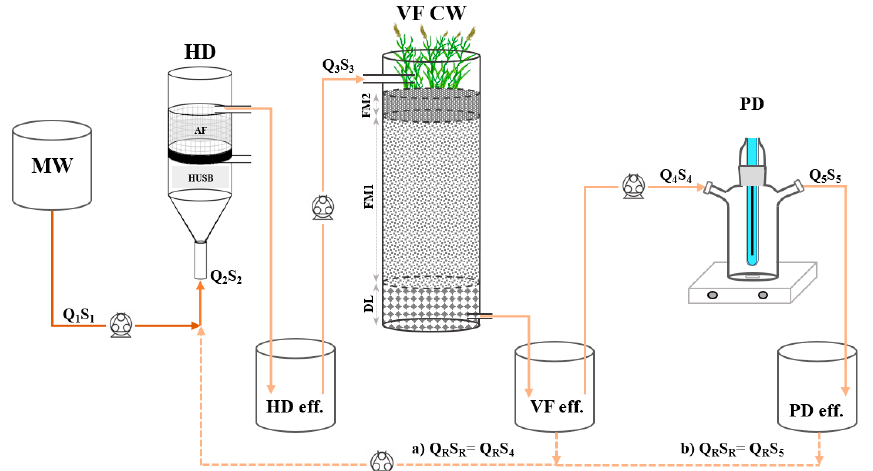
Figure 1. Scheme of the combined HD–VF–PD system with recirculation of VF effluent (a) or PD effluent (b). Acronyms: MW, municipal wastewater; HD, hybrid digester; VF, vertical flow unit; FM, filtering medium; DL, drainage layer; PD, photodegradation lamp; Q, flow; S, substrate concentration. Recirculation options: (a) from VF unit, (b) from PD unit.